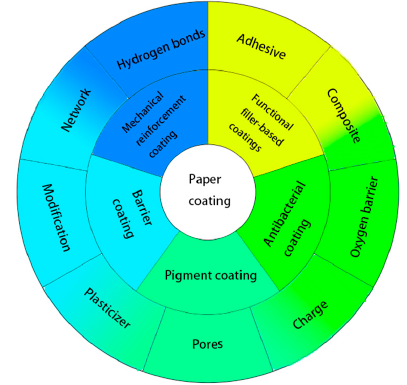
Figure 1. Factors affecting the properties of different types of paper coatings. Figure 1. Factors a ff ecting the properties of di ff erent types of paper